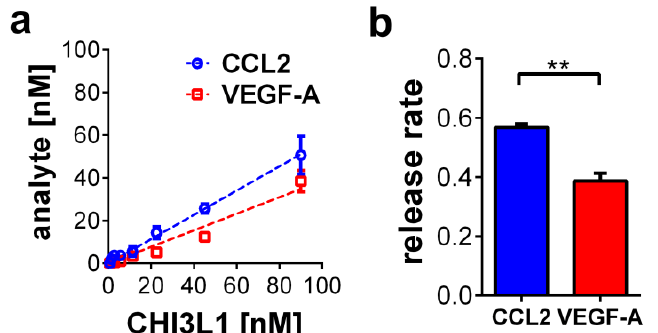
Figure 5. CHI3L1-mediated release of CCL2 and VEGF-A from HS. ( a ) CHI3L1 dose-dependent liberation of CCL2 and VEGF-A. n = 3–4 ( b ) Release rate of CCL2 and VEGF-A. n = 3–4; ** p ≤ 0.01 ANCOVA.